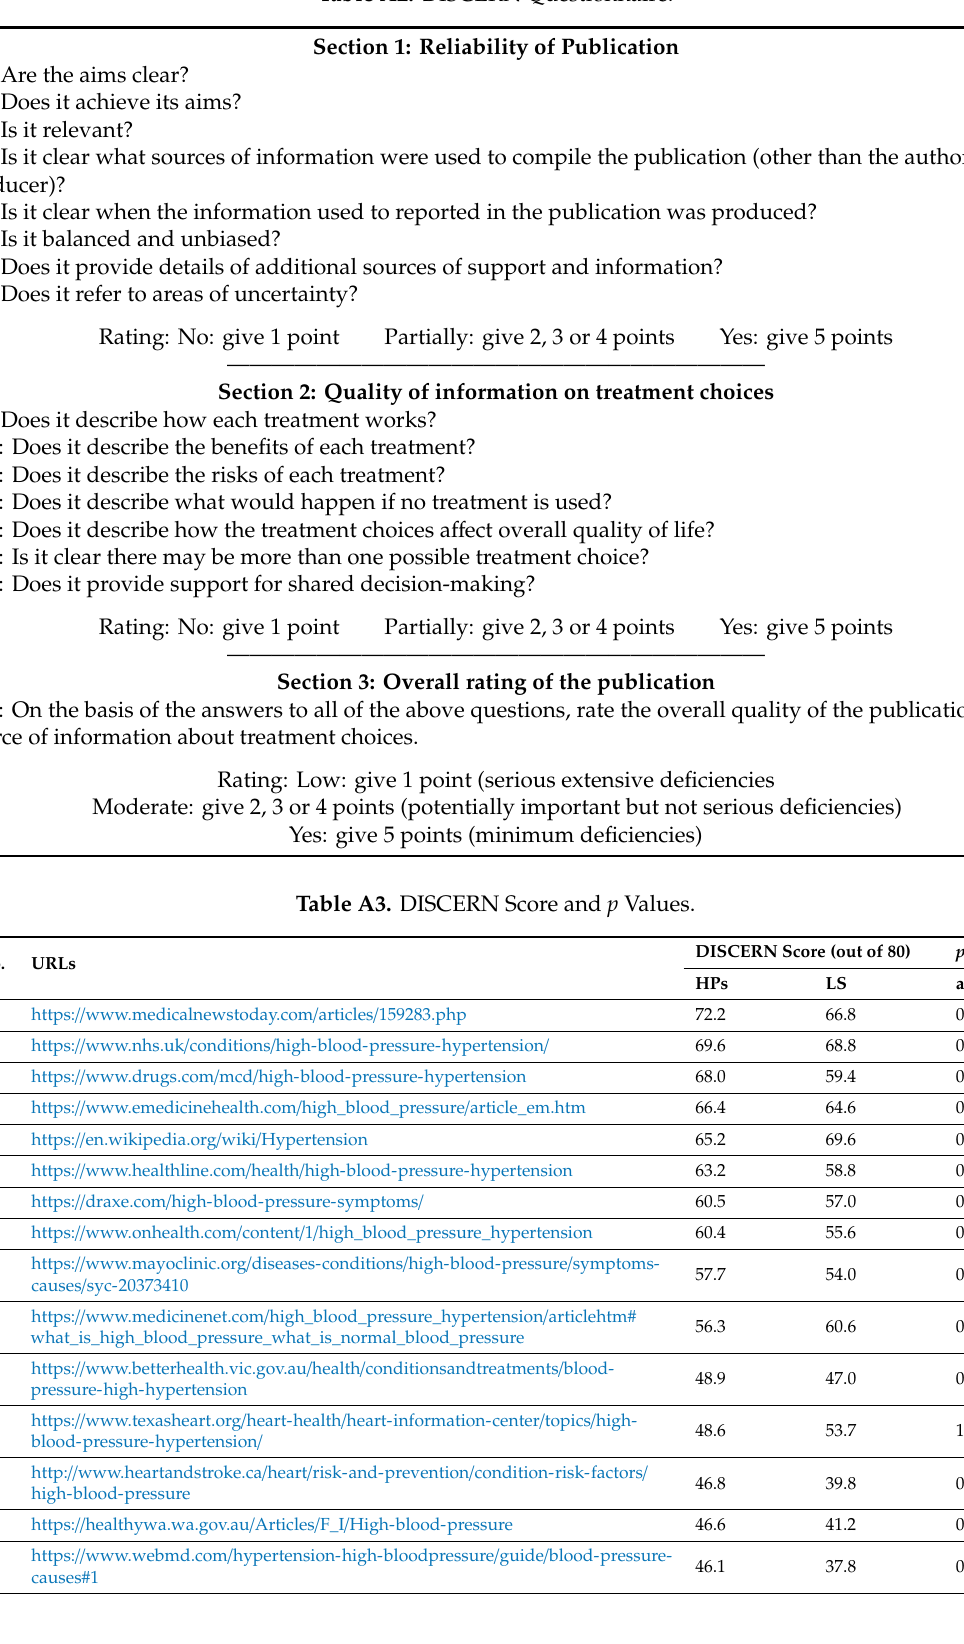
Table A2. DISCERN Questionnaire.